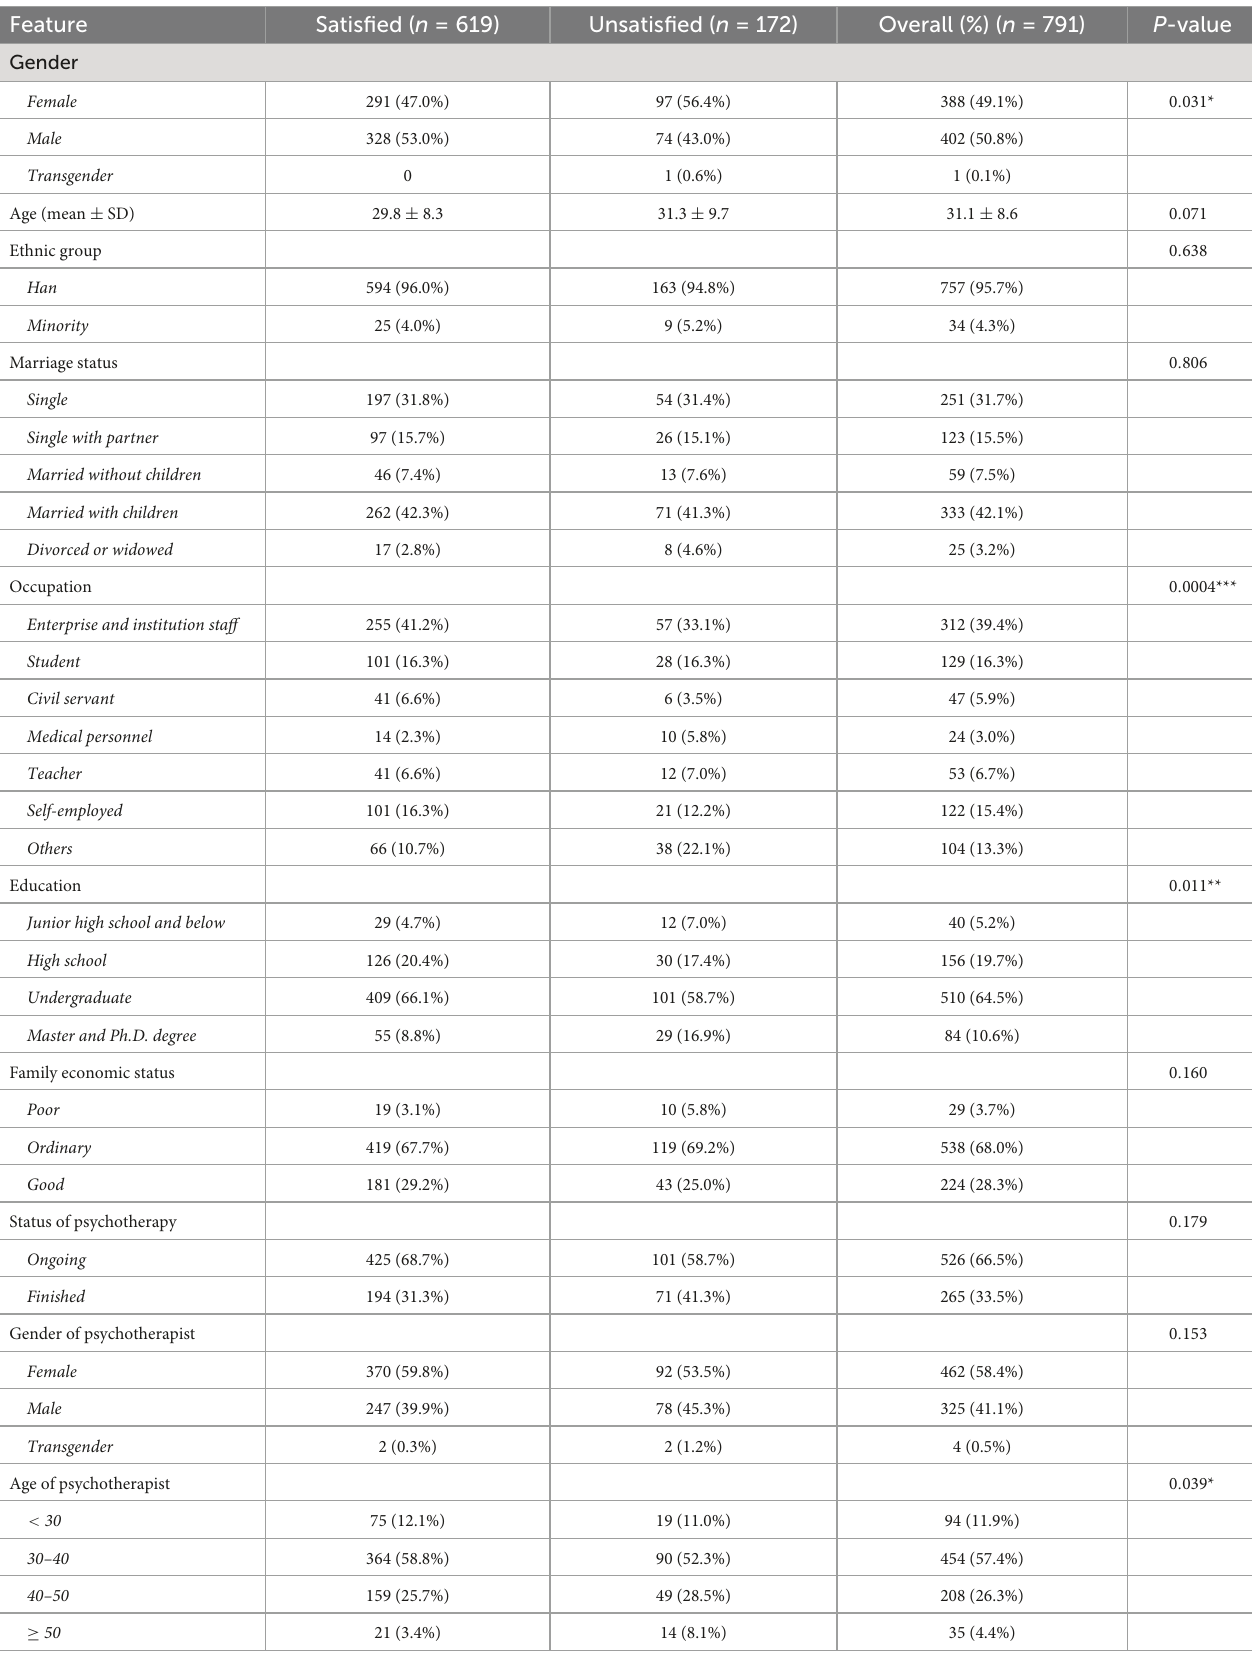
TABLE 1 Features of participants involved in the